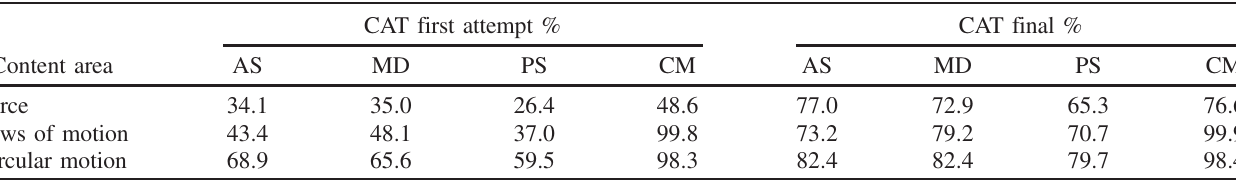
TABLE III. Class average percent scores in core competencies (AS,MD,PS,CM) at the beginning (first four columns) and at the end (last four columns) of CAT for three successive content areas in the spring 2017 semester for the CB class. In each successive content area, learners achieved a higher score in each competency at their first attempt of the CAT than they had in the former content area. Also, in all the competencies the class ’ s average scores improved over the period a CAT was available for